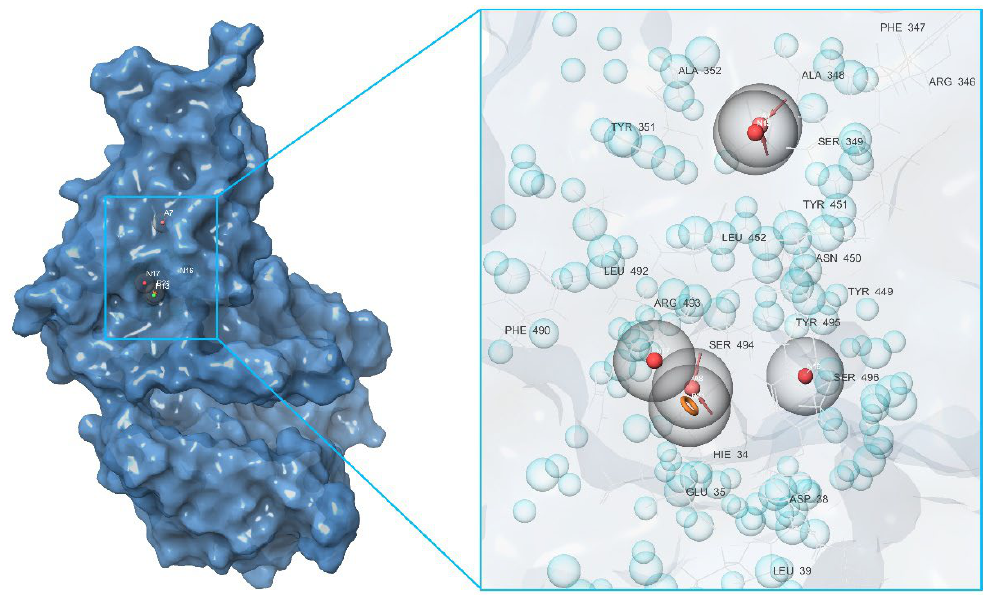
Figure 5. Pharmacophore model of the RBD site b of a spike protein generated by the Receptor cavity method.